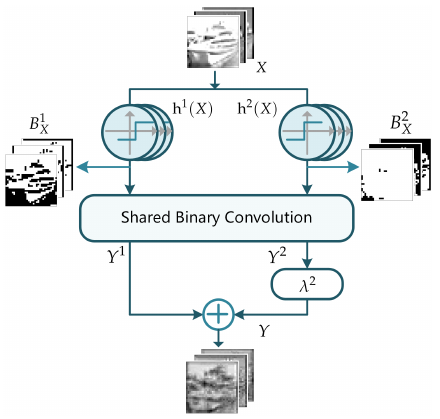
Figure 3. The structure of the IE-BC when K = 2. The 32 × 32 input activation X is binarized to the different binary activations B 1 and B 2 by two RSign functions. Then, a shared binary convolution X X is used to process the binary activations and generates the outputs Y 1 and Y 2 . In the end, the final output is derived by the summation of Y 1 and Y 2 · λ 2 , according to Equation